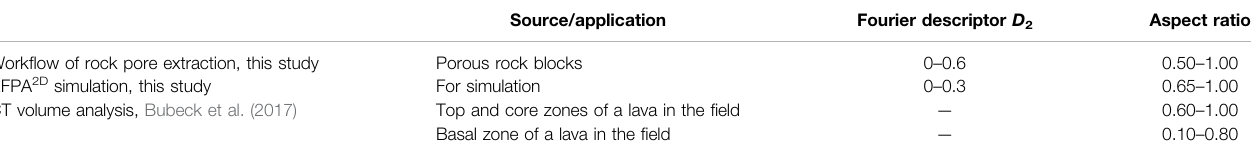
TABLE 4 | Comparison between pore aspect ratio obtained by Bucket et al. (2017) and converted by D 2 in this study.